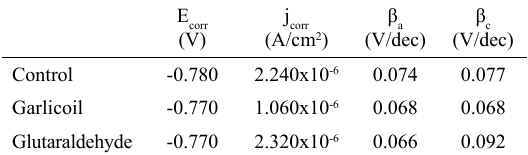
Figure 6. Polarization curves for the 1020 carbon steel in synthetic seawater. The coupons were previously incubated in SRB-containing culture medium in the absence and presence of the studied biocide Table 2. Electrochemical parameters obtained from the Tafel extrapolation of the polarization curves presented in Figure